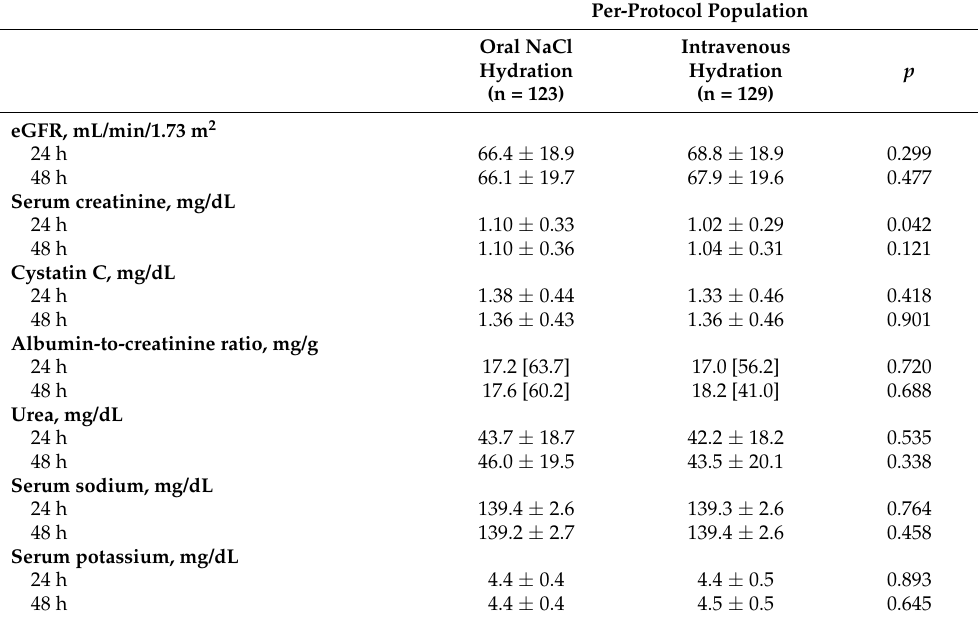
Data expressed as mean ± standard deviation or median [interquartile range]. eGFR: estimated glomerular filtration rate according to